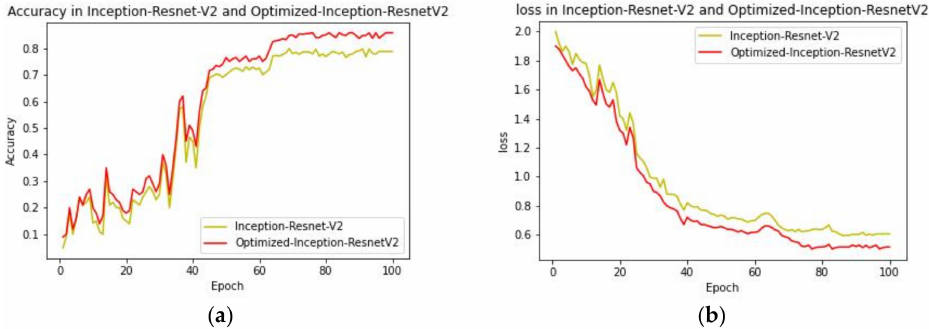
Figure 14. The changing situation of the recognition accuracy and the loss function with the epochs during the training process on NEU-DET dataset. ( a ) the changing situations of the accuracy. ( b ) the changing situations of the loss.